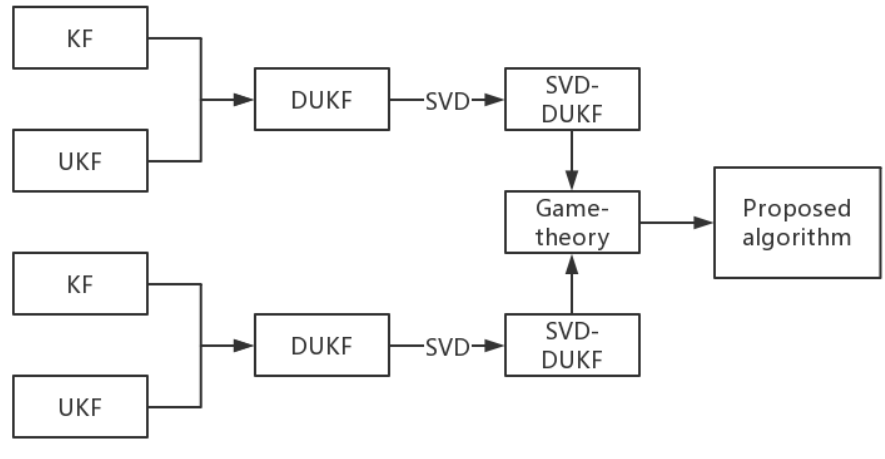
Figure 1. Schematic diagram of the relative